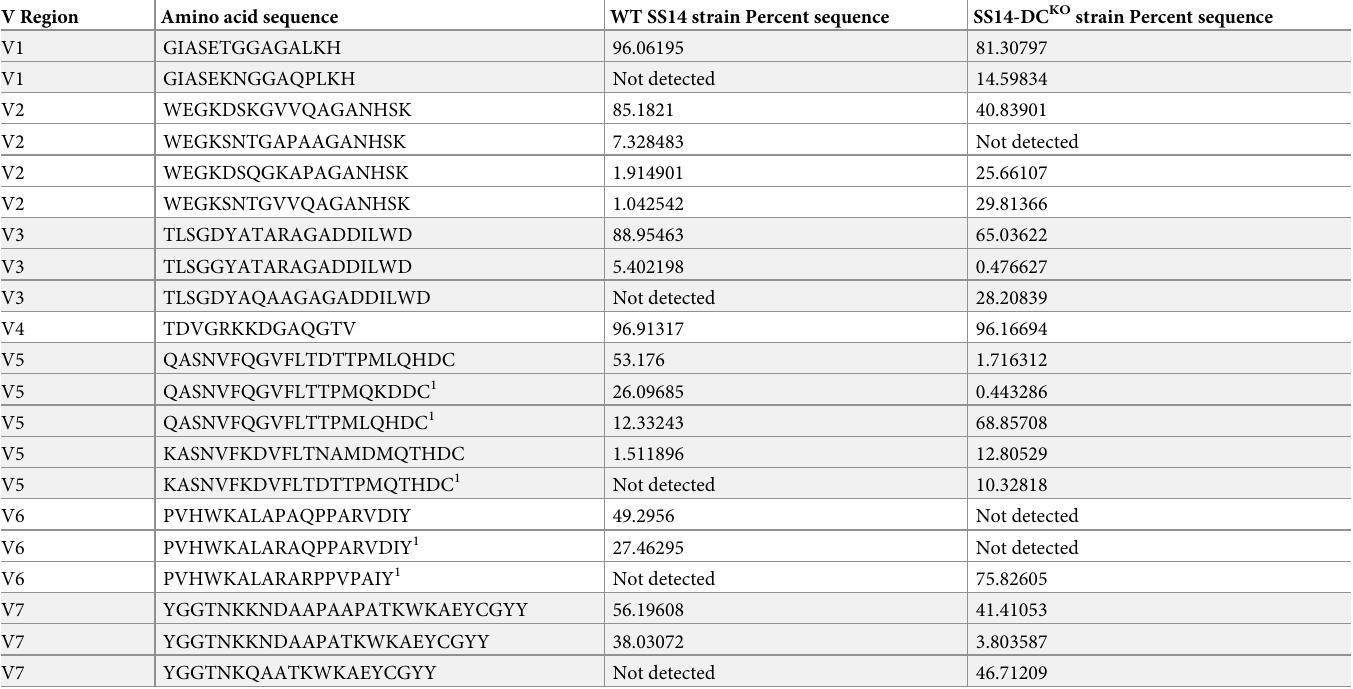
Table 3. TprK variability profile in the SS14 and SS14-DC KO strains used for rabbit ID inoculation. V Region Amino acid